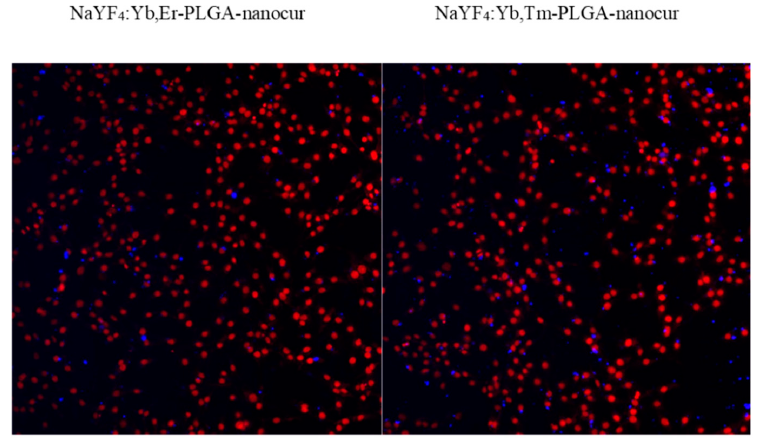
Figure 12. Micrographs of rat C6 glioma cells under a fluorescence microscope: UCNPs concentration 0.05 mg/mL, 30 min of incubation. Cell nuclei are marked in red, the fluorescence of nanocurcumin is marked in blue. Excitation of nanocurcumin was induced by irradiation at 488 nm. Lens 10×.